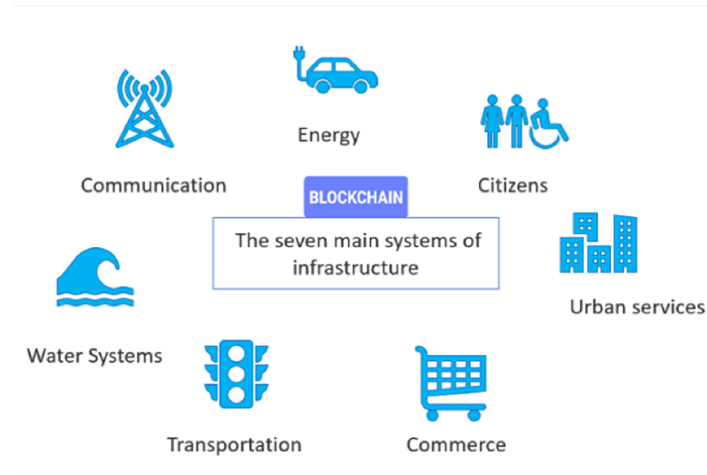
Figure 4. The seven major systems of